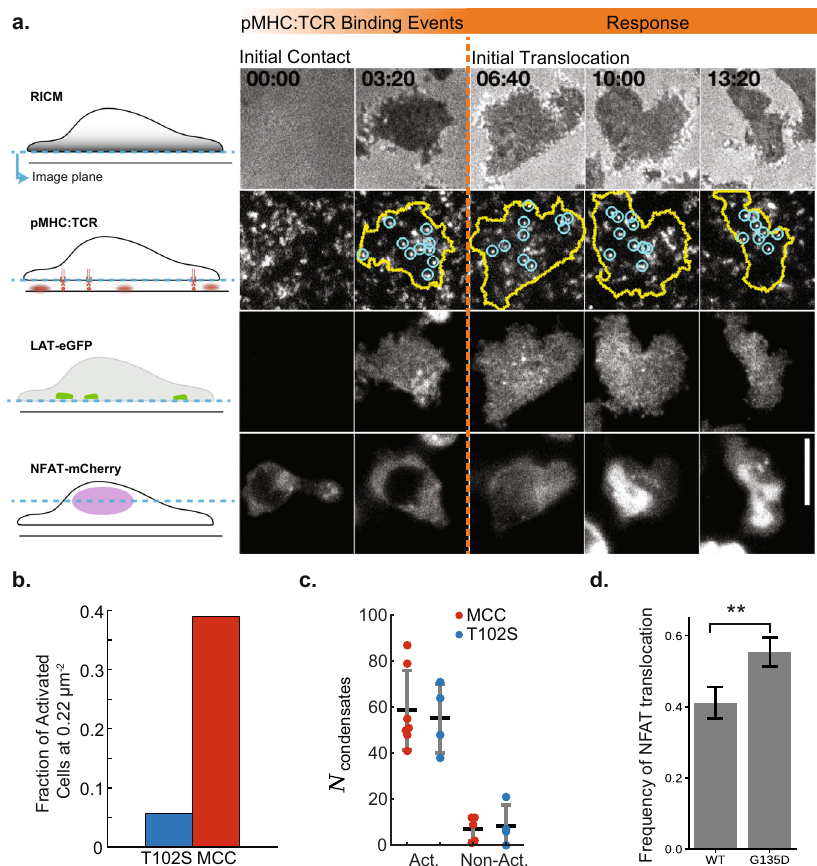
Fig. 6 | Modulating LAT condensate delay time alters antigen discrimination thresholds. a Images of key molecular steps leading to NFAT translocation through time within primary T cells. The cells were deposited onto supported membranescontainingICAM-1andMCC(Atto647)pMHC.Firstrow,RICMdetects cell spreading and ensures the T cell has good contact with the supported membrane. Second row, TIRF images of individual pMHC:TCR binding events (blue) are recorded within the cell perimeter (yellow). Third row, TIRF images of LAT-eGFP is monitored for condensation events. Fourth row, epi fl uorescence images of NFAT to track moment of translocation. Scale bar is 5 μ m. b Bar plot showing the frequency of T cells that undergo NFAT translocation for either T102S ( n cells =27) or MCC ( n cells =24) at a fi xed peptide-MHC density of